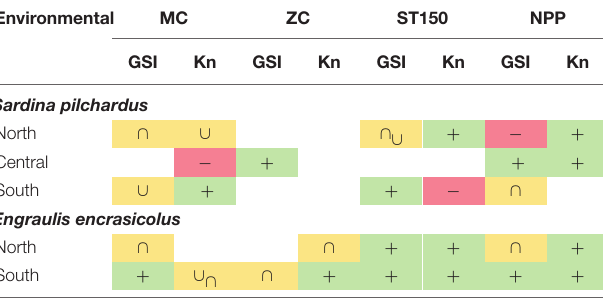
Decrease or negative ( − ) relationship is indicated with red, increase or positive relationship ( + ) is indicated in green and ( ∩ ) dome shaped and ( ∪ ) U shaped relationships are indicated in